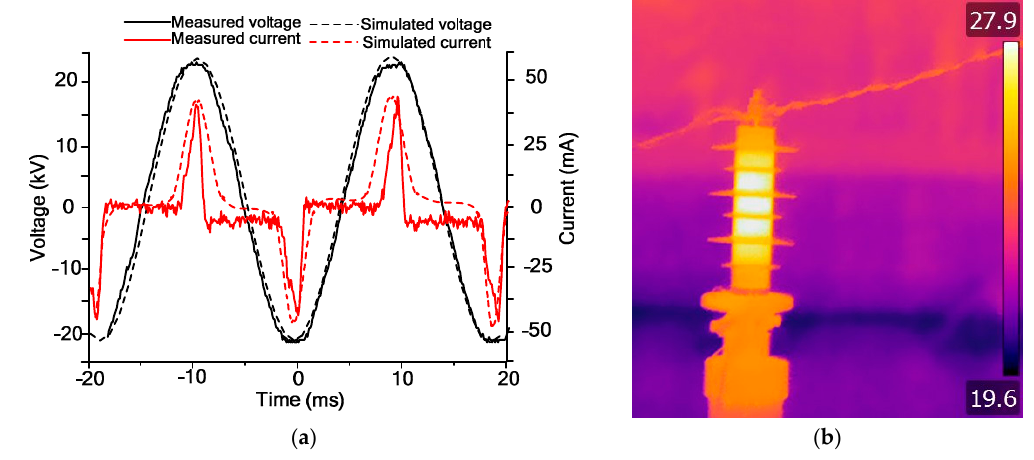
Figure 10. Electrothermal characteristics of MOA under the applied voltage of 17.4 kV. ( a ) Voltage and current time curves/courses; ( b ) thermal picture.